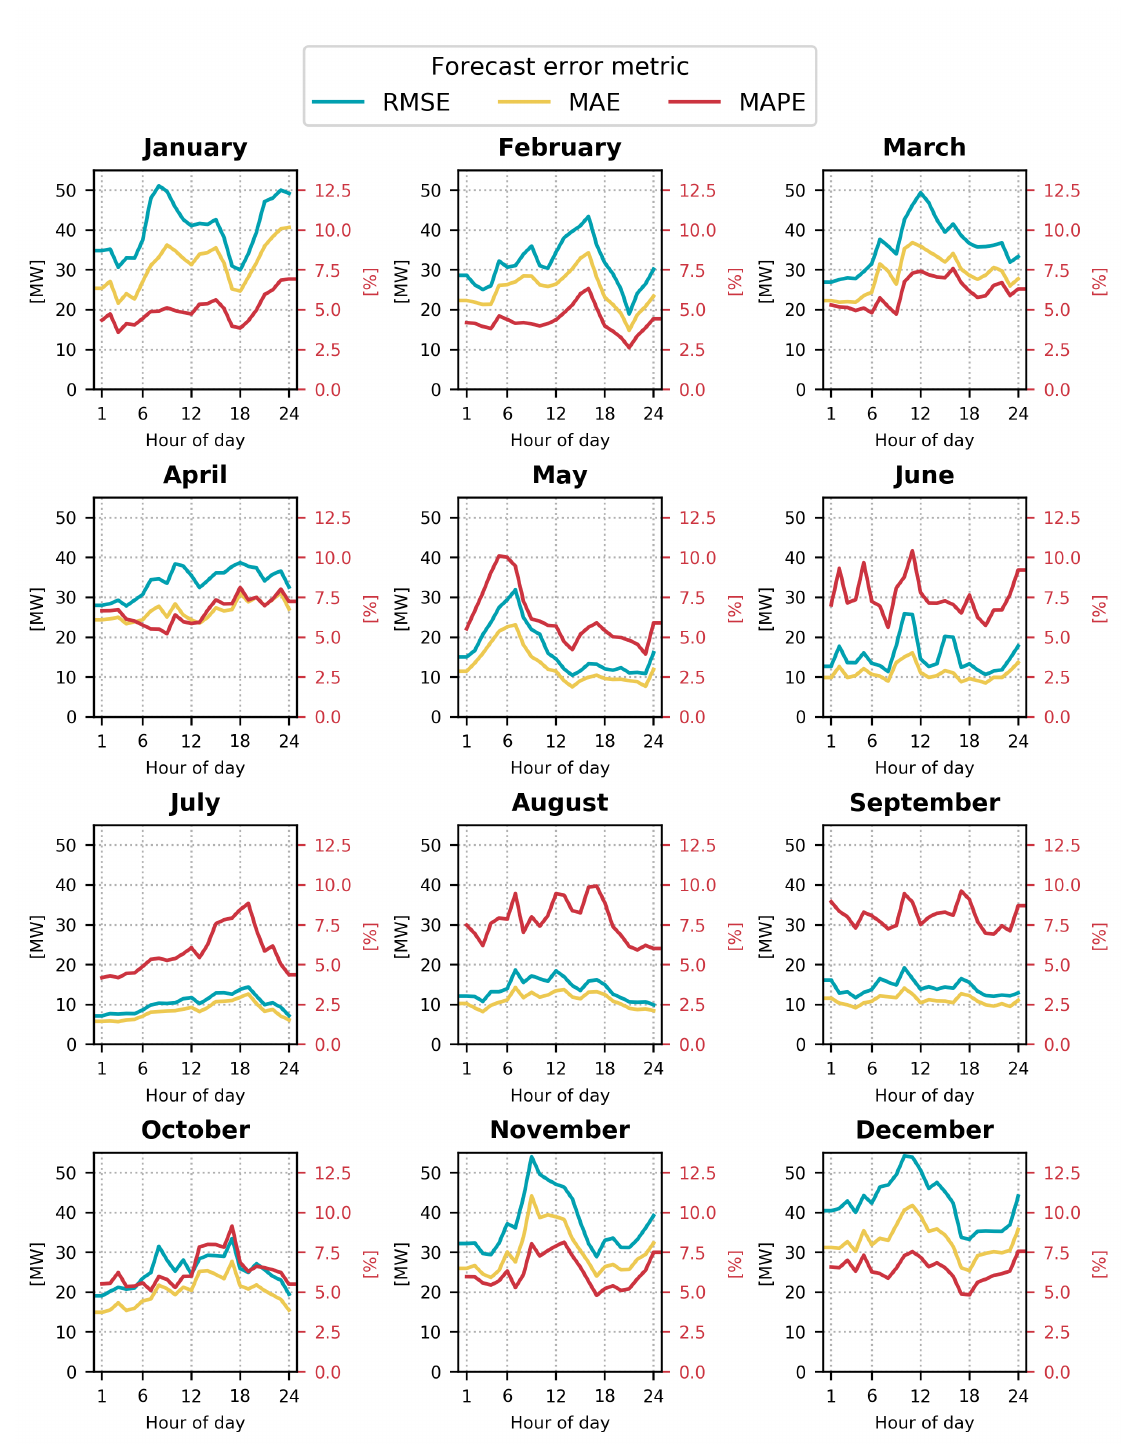
Figure 5. Performance of the SVR model on the year 2016, using real weather forecasts, calendar, and holiday data. Three different error metrics are shown for each month of the year. The forecast error varies with the time of day, shown on the horizontal axes. RMSE (blue) and MAE (yellow) are shown units of MW on the left axes. MAPE (red) is shown in percent on the right